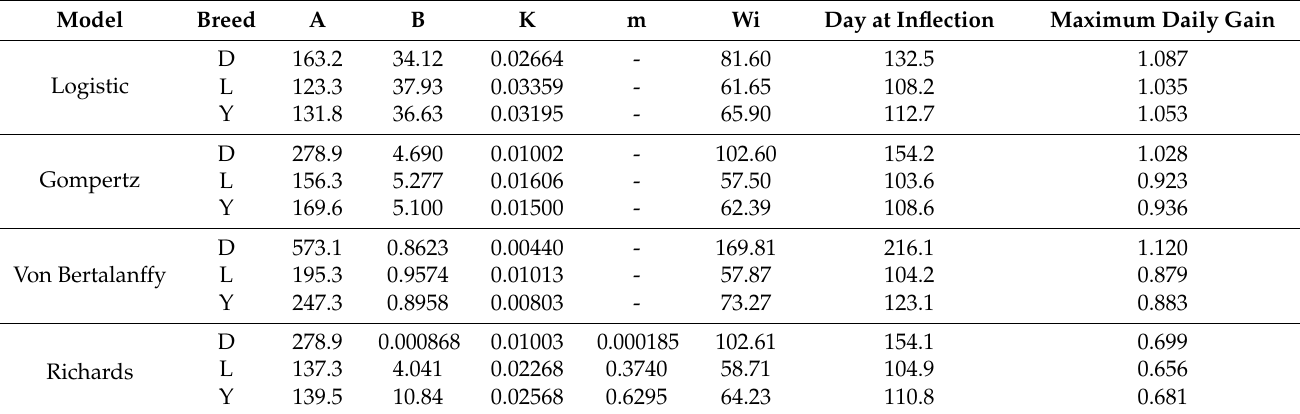
Table 2. Estimates of growth curve fitting